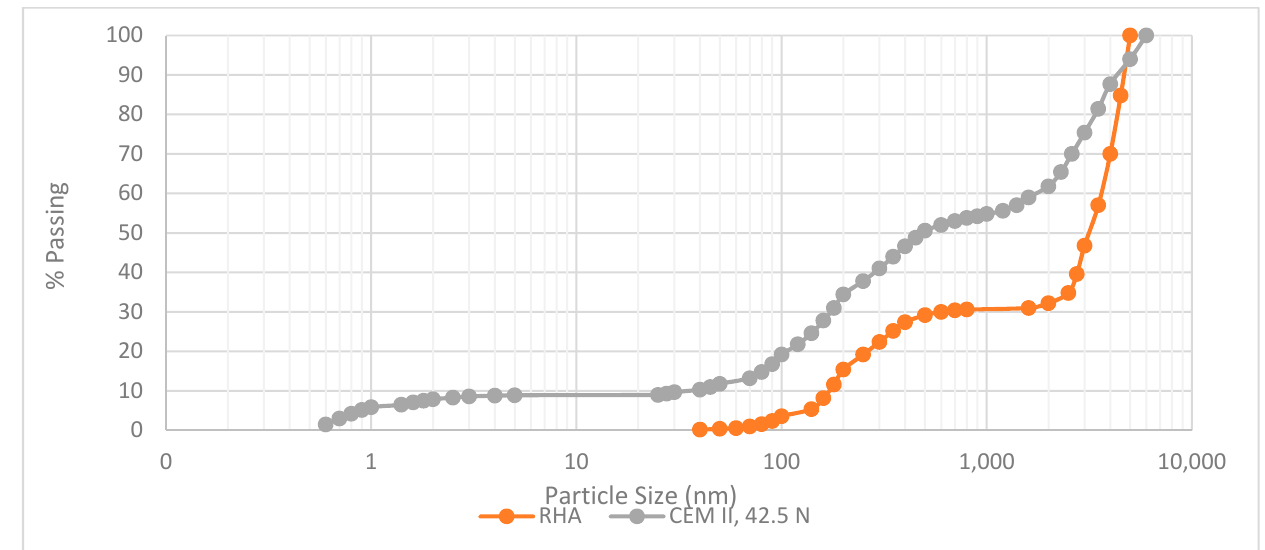
Figure 1. Particle size distribution of binders. Table 3. Physical properties of binder materials. (Nduka et al.,